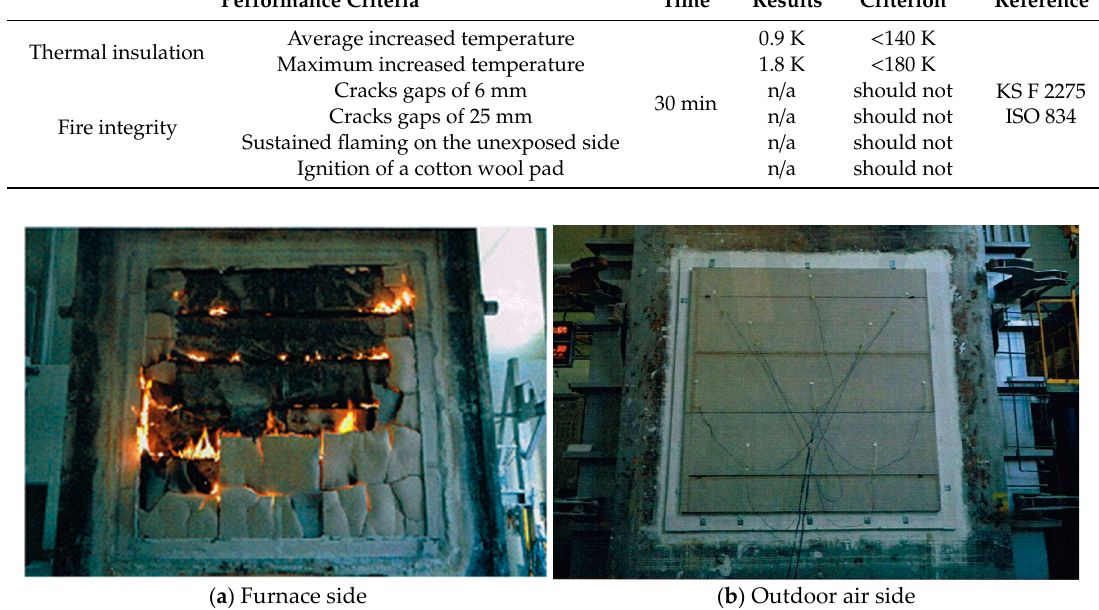
Figure 6. Specimen after the fire resistance test.